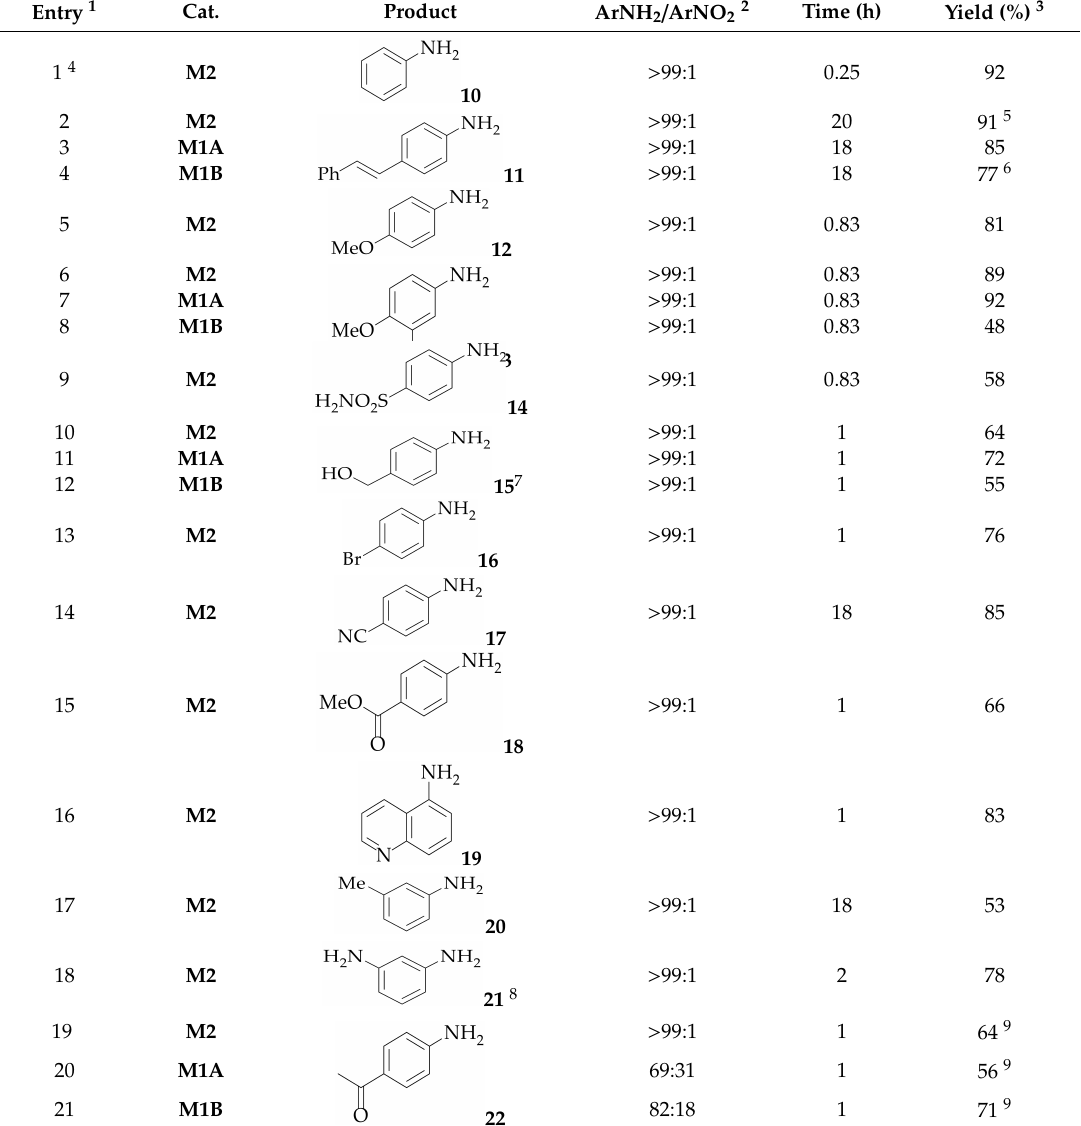
Table 7. Reduction of nitroarenes with AB under catalysis by Rh